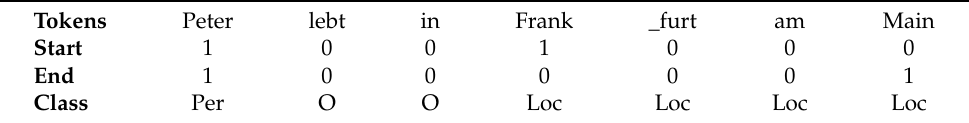
Table 4: finding start and end tokens and learning the correct class. Table 4. CSE tagging example. Rows refer to the tokens and its respective target for start, end, and